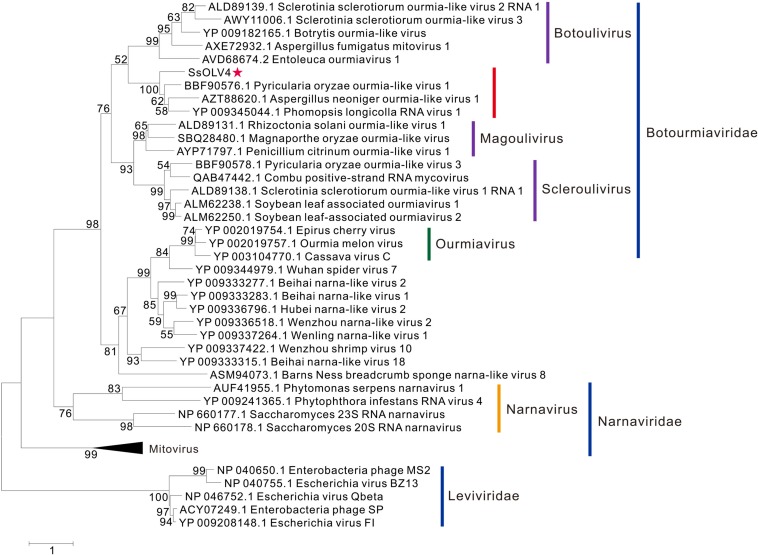
Maximum likelihood phylogenetic tree based on the RdRps of SsOLV4 and other related viruses. Proteins were aligned with MUSCLE implemented in MEGA 7. The multiple alignments of RdRp regions were based on the RdRp region of SsOLV4. The phylogenetic tree was generated using the software MEGA7. The bootstrap values (%) obtained with 1,000 replicates are indicated on the branches. Branches with bootstrap values of <50 have been collapsed. The scale bar at the lower left corresponds to a genetic distance of 1. SsOLV4 is marked by a red star. The lines with different colors represent the clade of each taxonomic status. The accession number in parentheses is in front of the virus name.